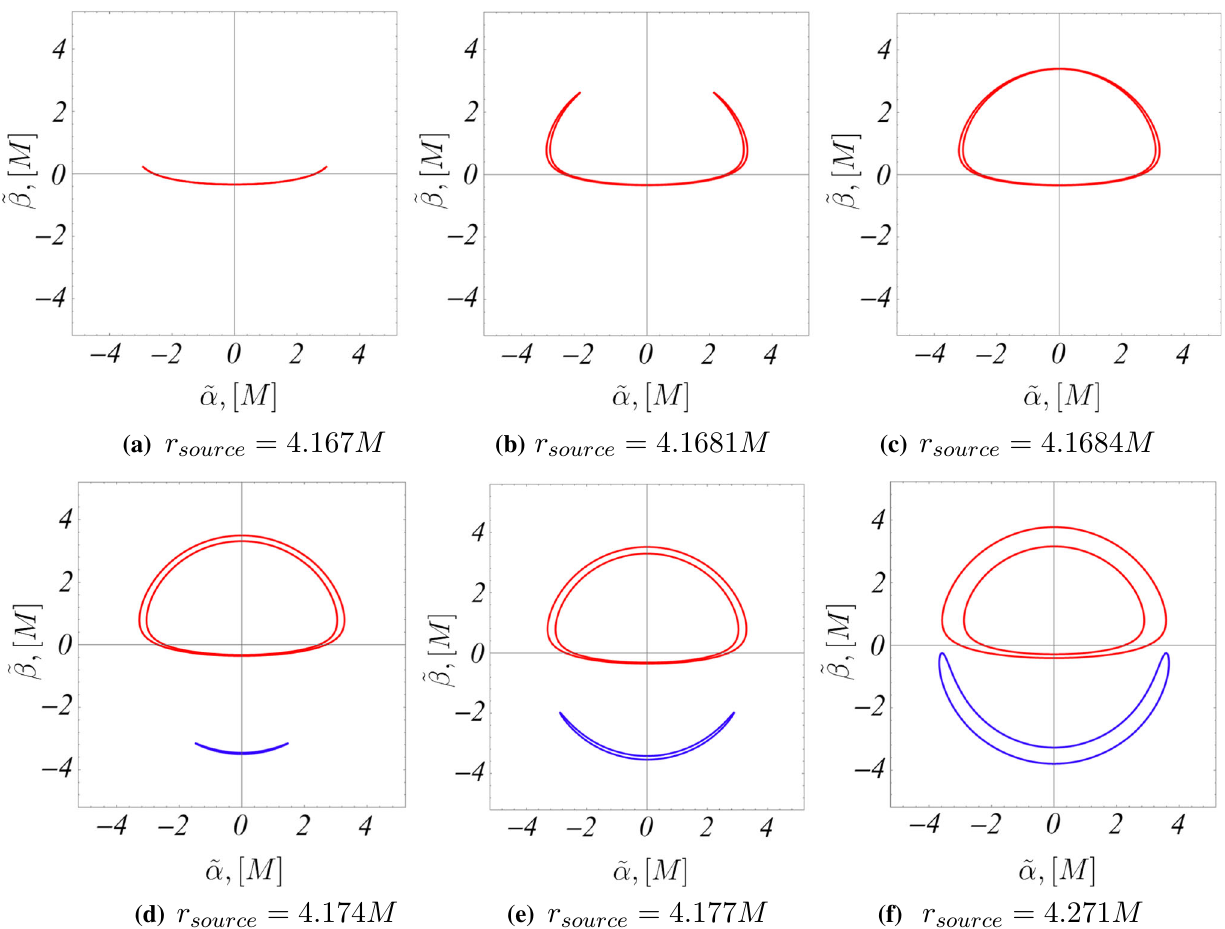
tions, which are indicated under each plot. We start from an orbit close to the curvature singularity at r source = 4 . 167 M and reach the inner disk limit located at the inner marginally stable orbit r − = 4 . 271